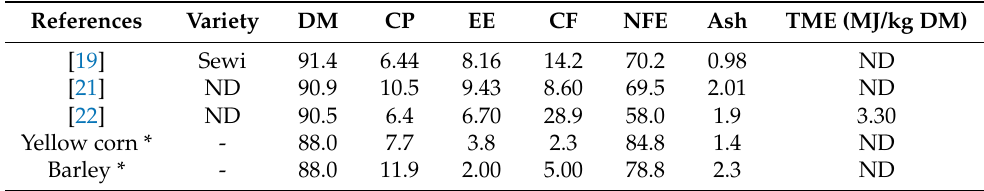
Table 1. Chemical composition (%) of different varieties of date stone meal compared with yellow corn and